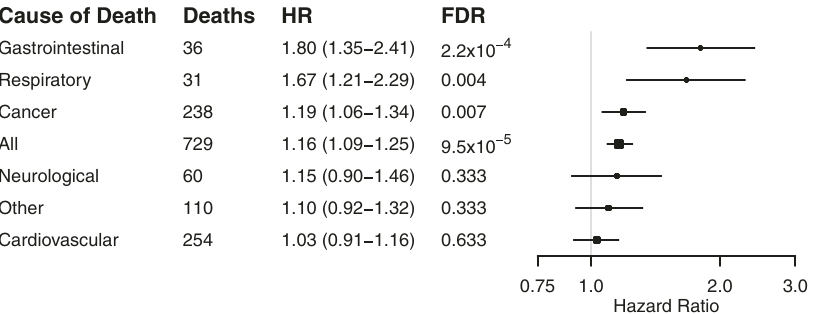
Fig. 3 The association between Enterobacteriaceae abundance and cause-speci fi c mortality. Cox hazard ratios and 95% con fi dence intervals are reported per unit variance increase in Enterobacteriaceae abundance. Box sizes are inversely proportional to P values. The entire study sample ( n = 7211) was examined independently with each cause of death as end point. Analyses are adjusted for age, body mass index, sex, smoking, diabetes, use of antineoplastic and immunomodulating agents, systolic blood pressure and self-reported antihypertensive medication. HR hazard ratio, FDR false discovery rate. Table 1 Cause of death speci fi c c -statistics for different feature sets.